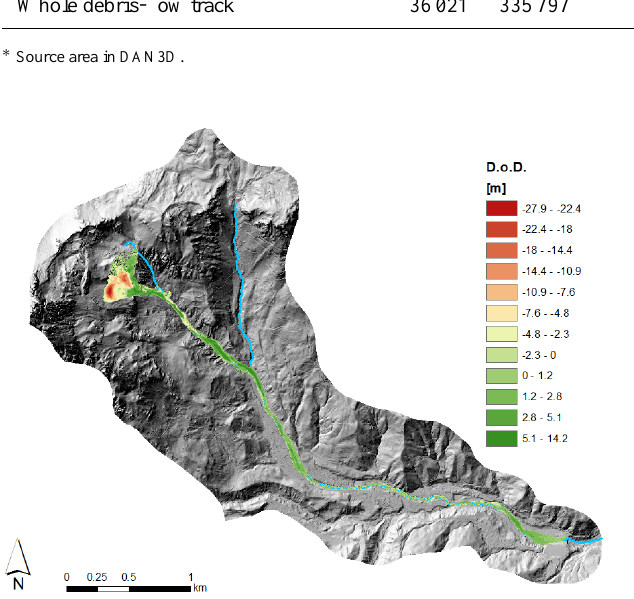
Figure 5. Results of the back-analysis simulation with DAN3D: dis- tribution of the